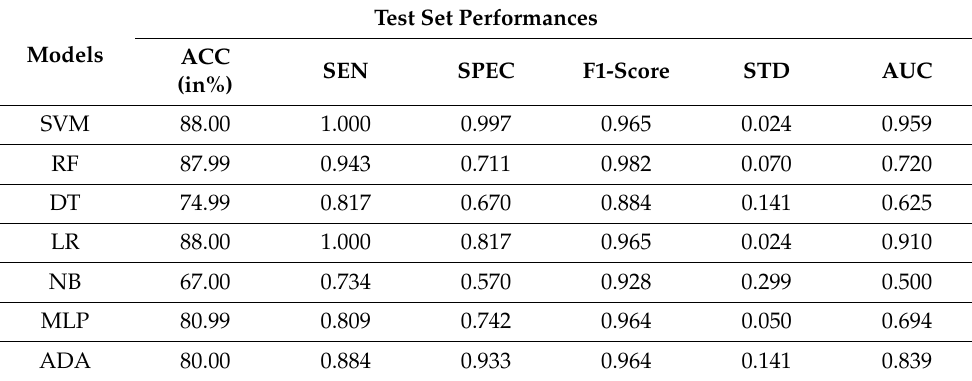
Table 6. Average performance with imbalanced data set using 5-fold